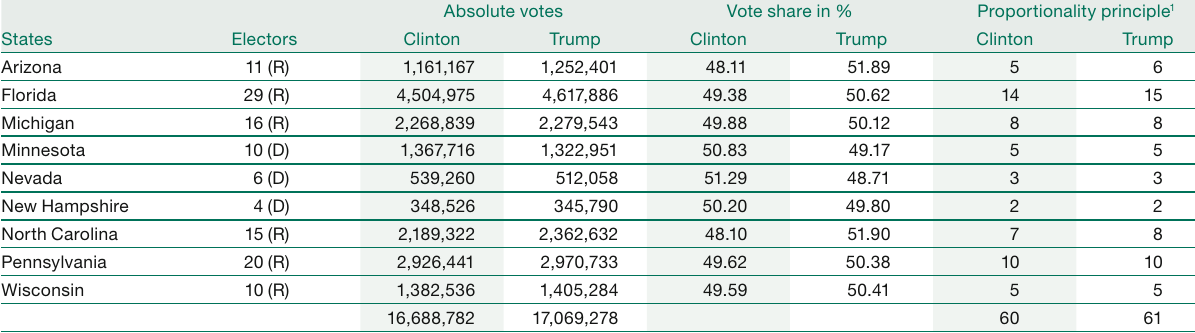
Partial results of the presidential election of 2016: Majority principle vs. proportionality